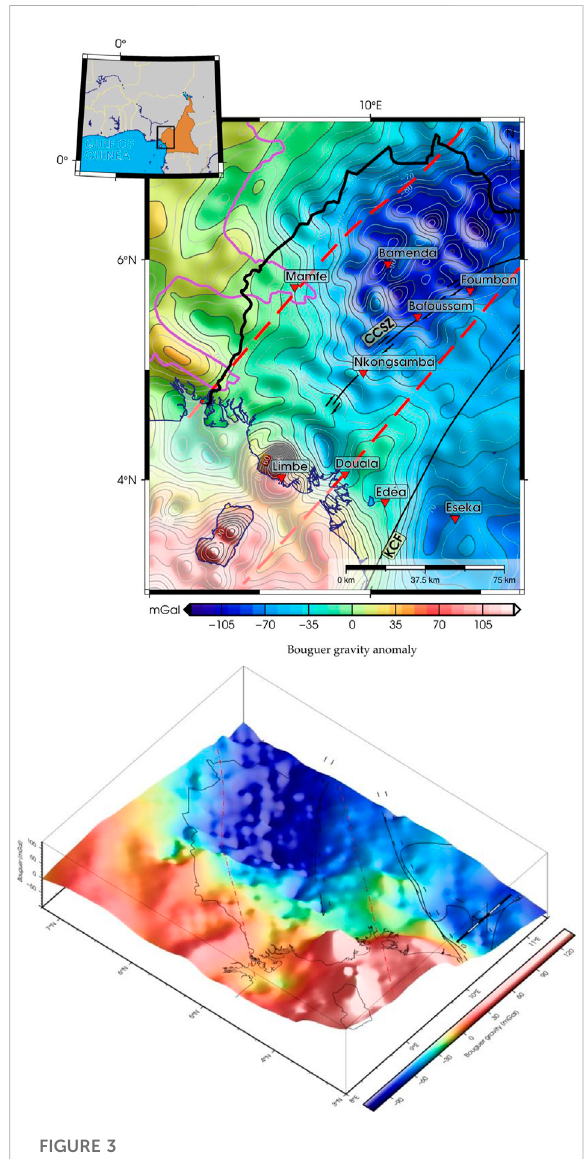
FIGURE 3 Bouguer anomaly map of the study area with its perspective representation, estimated on a 0.1 ° × 0.1 ° geographical grid (black lines represent national